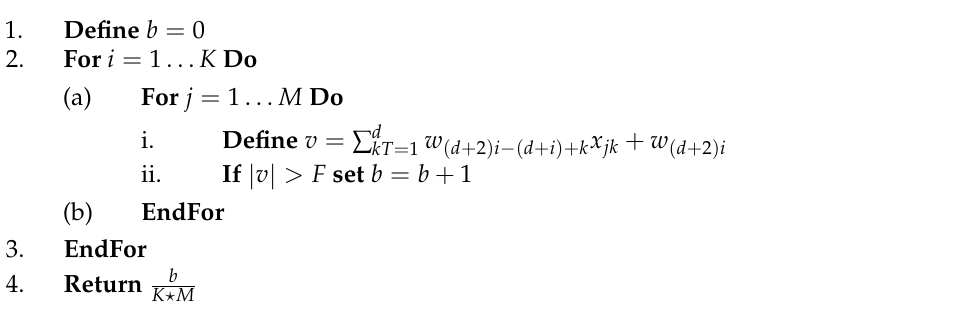
Algorithm 1 Calculation of the bounding quantity for neural network N ( x , w